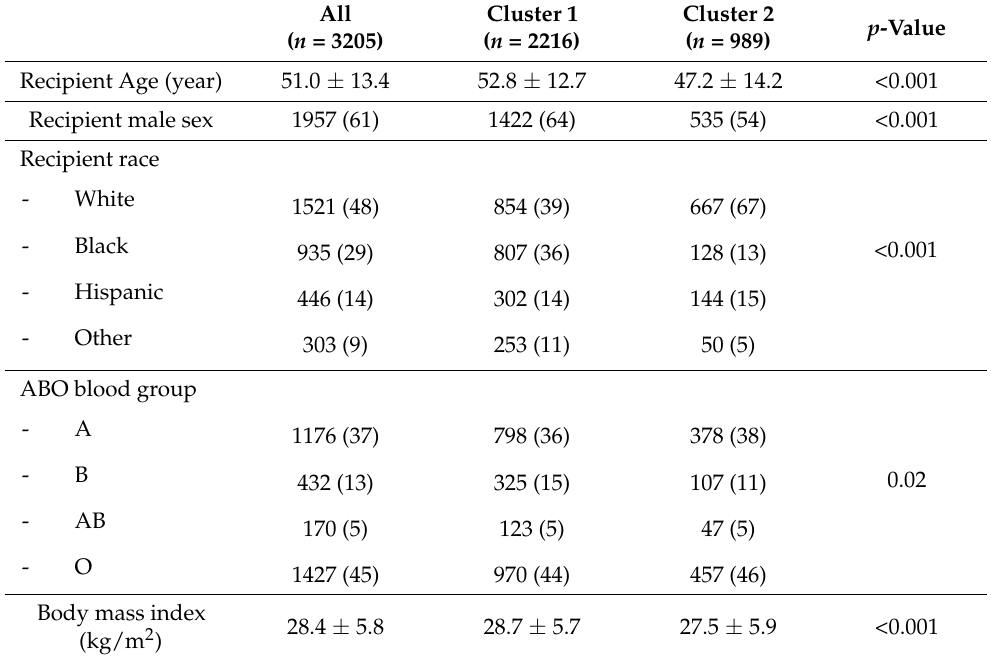
Table 1. Clinical characteristics according to clusters of functionally disabled kidney transplant recipients.